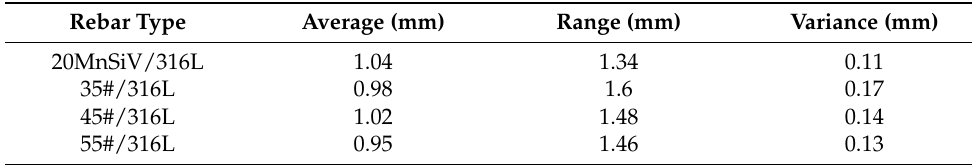
Table 3. Average, range, and variance for various